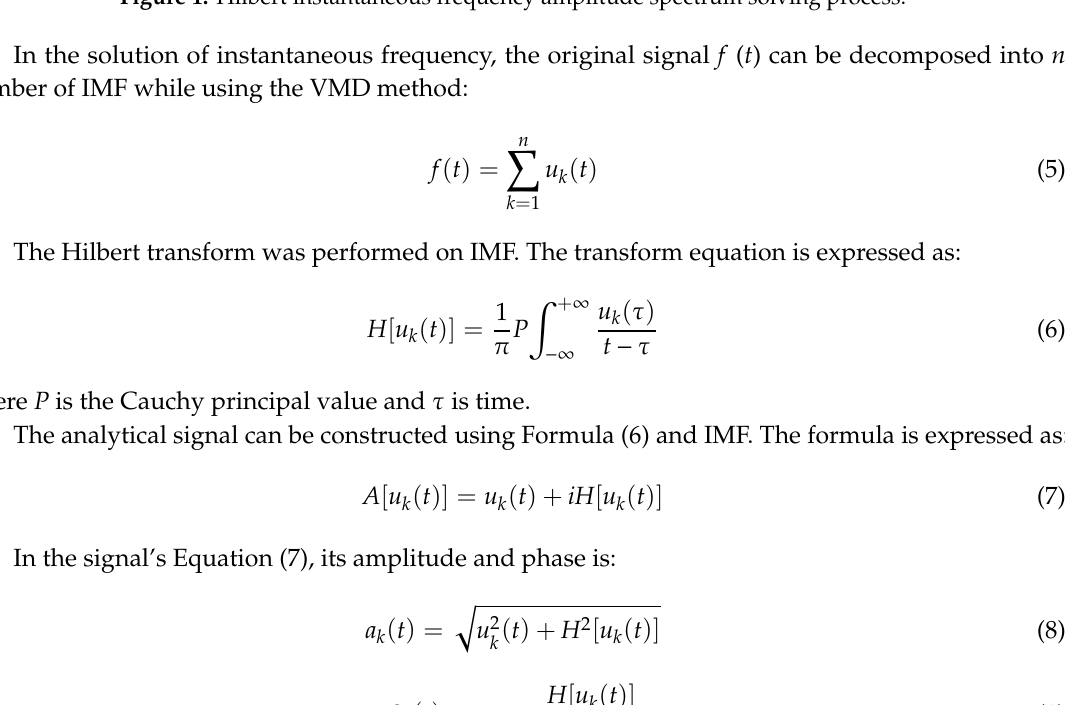
Figure 1. Hilbert instantaneous frequency amplitude spectrum solving process.